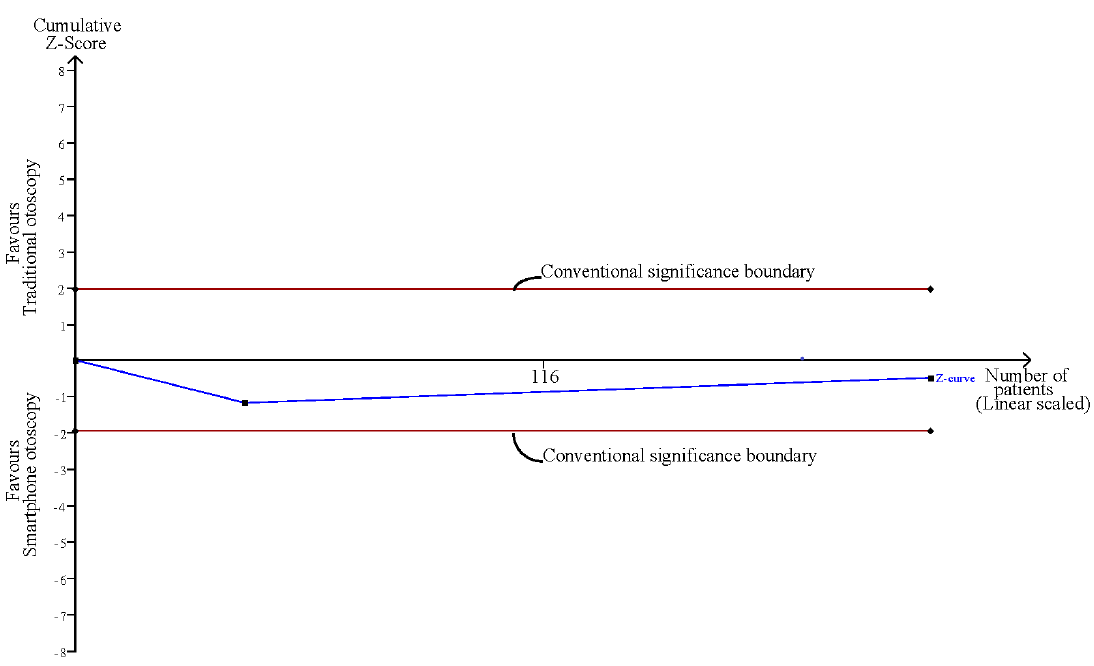
Figure 11. TSA of the confidence comparison between smartphone-enabled otoscopy and traditional otoscopy .